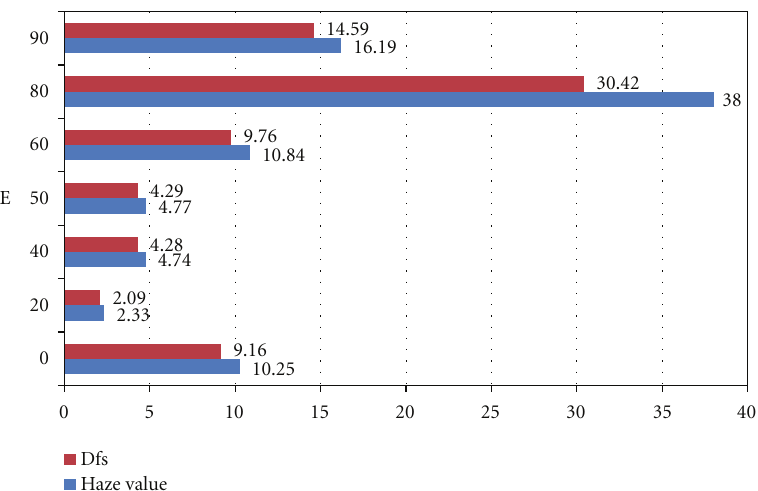
Figure 8: The haze values and percentage of light di ff used of the dried sol-gel from the mixture of silane and ethanol.